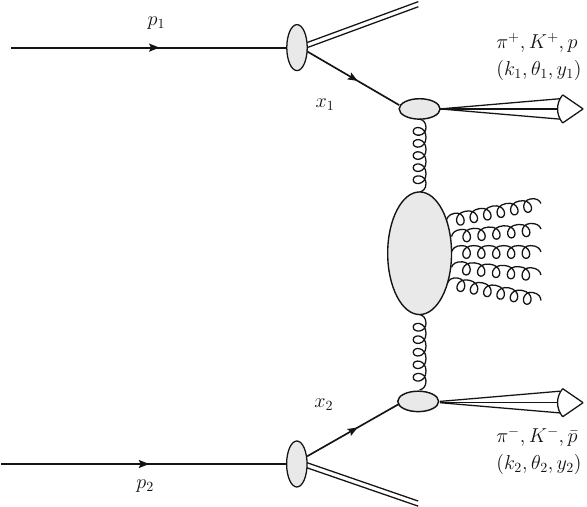
Fig. 1 Inclusive dihadron production process in multi-Regge kinemat- ics